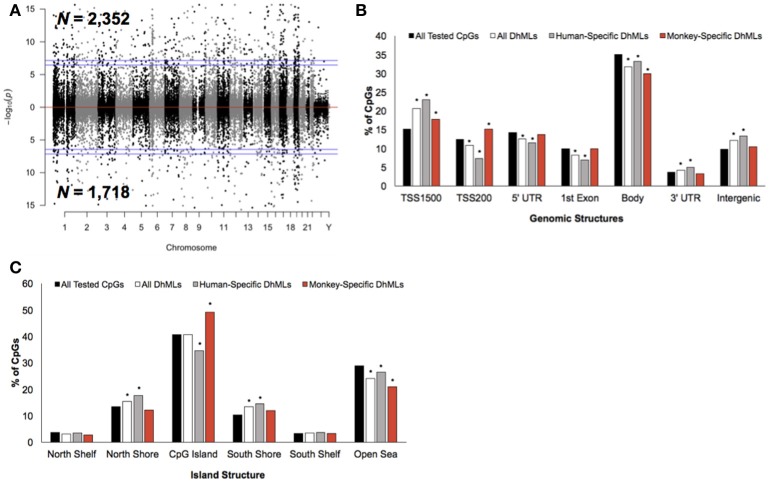
Characterization of DhMLs across standard genomic structures. (A) Modified Manhattan plot of species-specific DhMLs from brain tissue reveals DhMLs to be distributed across the entire human genome. Human-specific and monkey-specific DhMLs are displayed with the –log10 of the raw P-value (y-axis). Significant DhMLs are displayed outside of the dashed lines (genome-wide significance of 0.05 and 0.01), while DhMLs alternate between black and gray to indicate each chromosome. (B) The percent distribution (y-axis) of all CpGs investigated (black), all DhMLs (white), human-specific DhMLs (gray), and monkey-specific DhMLs (red) in each genomic structure are shown. Significant over- and under-representation of DhMLs are indicated (*P < 0.01). (C) The percent distribution (y-axis) of all CpGs investigated (black), all DhMLs (white), human-specific DhMLs (gray), and monkey-specific DhMLs (red) in each island structure are shown. Significant over- and under-representation of DhMLs are indicated (*P < 0.01).